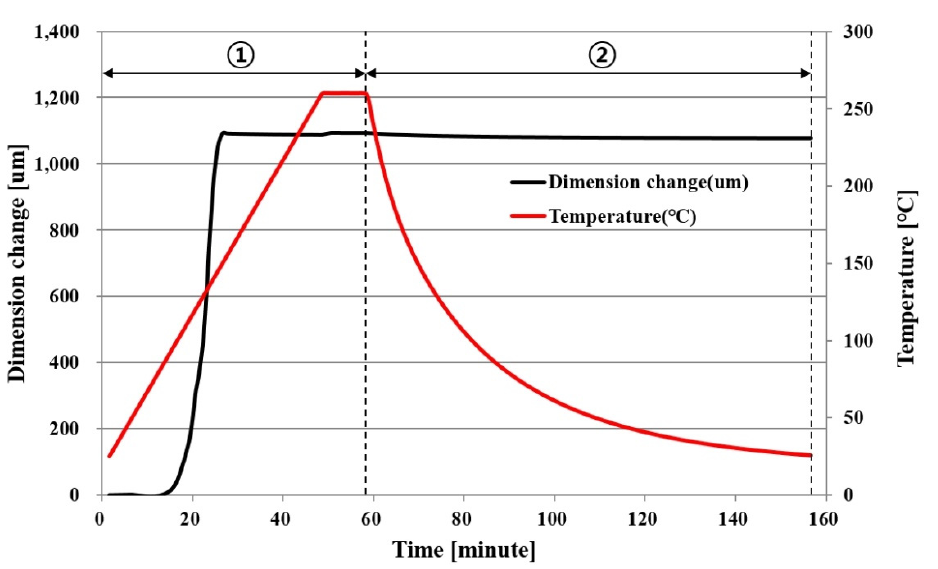
Figure 3. CTE of PPG in an x direction as a function of temperature and time. Table 1. CTE of PPG in an x direction.